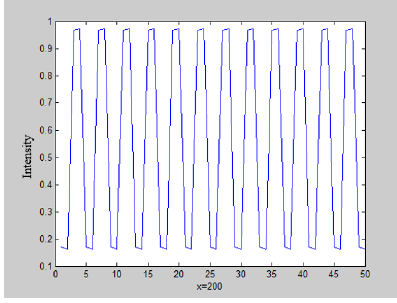
Figure 3. The intensity of interference fringes at x = 200 The modulation degree of Figure 3 is calculated as 0.71 through eq. (7).